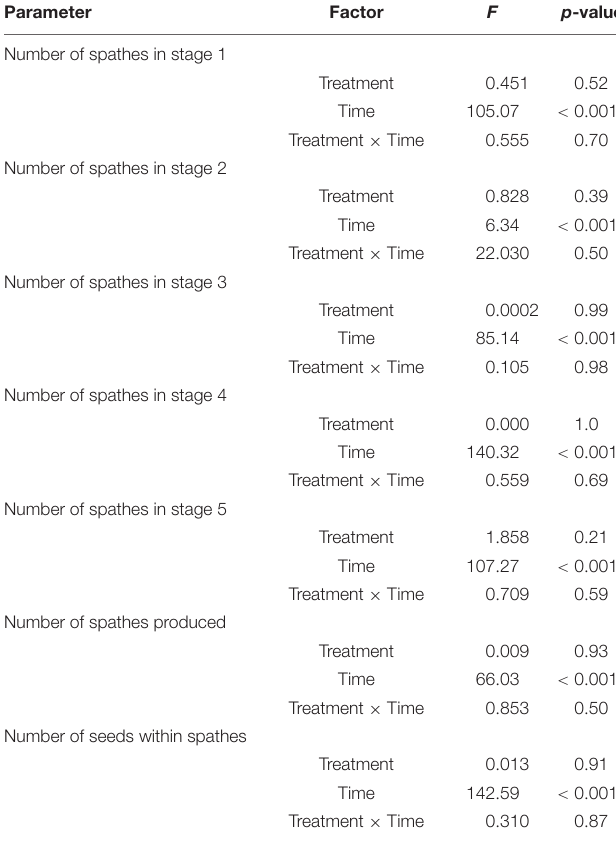
TABLE 2 | Results of repeated measures two-way ANOVA testing for the effects of treatment condition (degrees of freedom, df = 1), time (df = 4), and their interaction (df = 4) on flower maturation (tested for differences in stages 1–5) and, spathe and seed production (Experiment